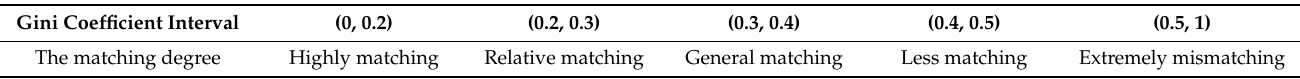
Table 1. Classification of the matching degree between land and water resources and GDP. Gini Coefficient